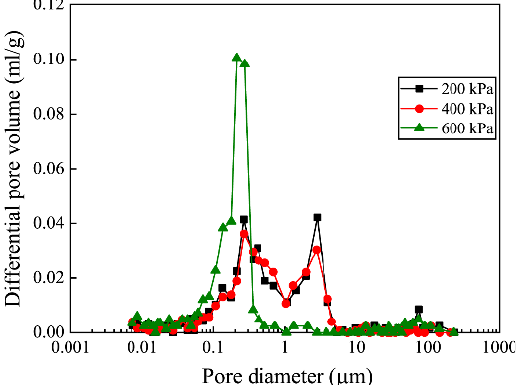
Table 5. Pore size distribution in Zhanjiang clay under different consolidation pressures [38].